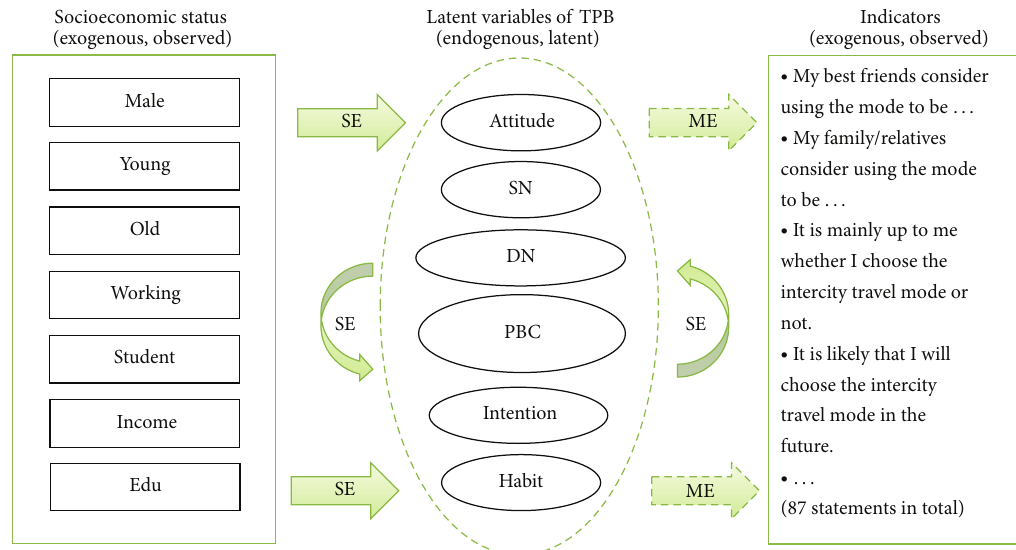
Figure 5: Multiple Indicators and Multiple Causes (MIMIC) model.